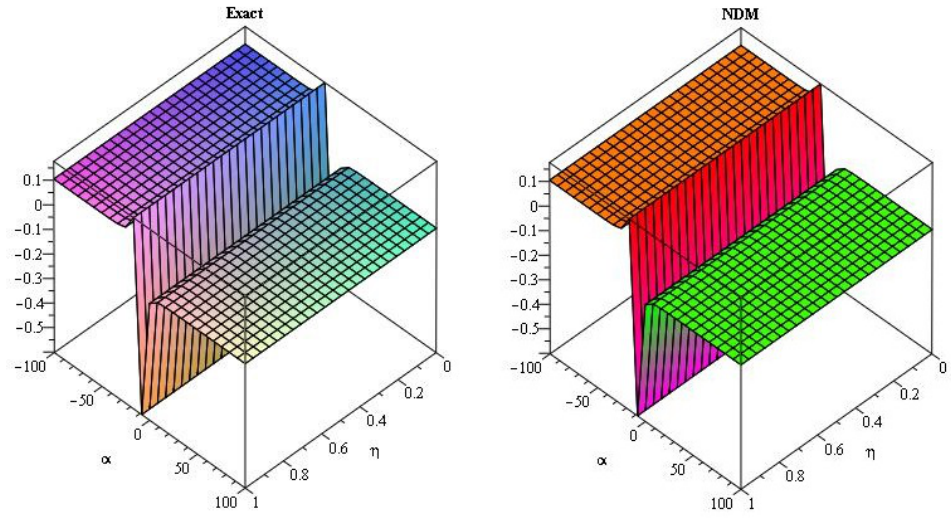
Figure 7. Exact and NDM solution of µ ( α , η ) at δ = 1.